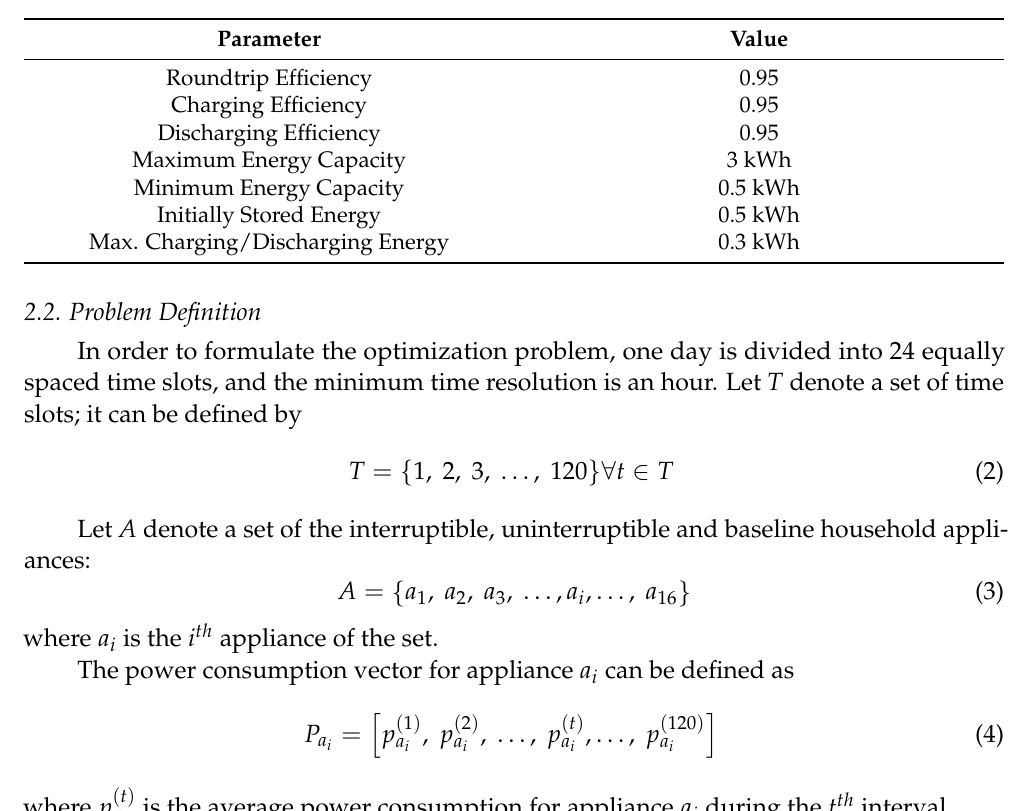
Table 3. The characteristics of the ESS in use